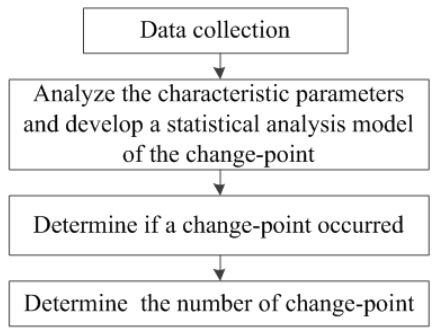
Figure 1. Change-point analysis process.